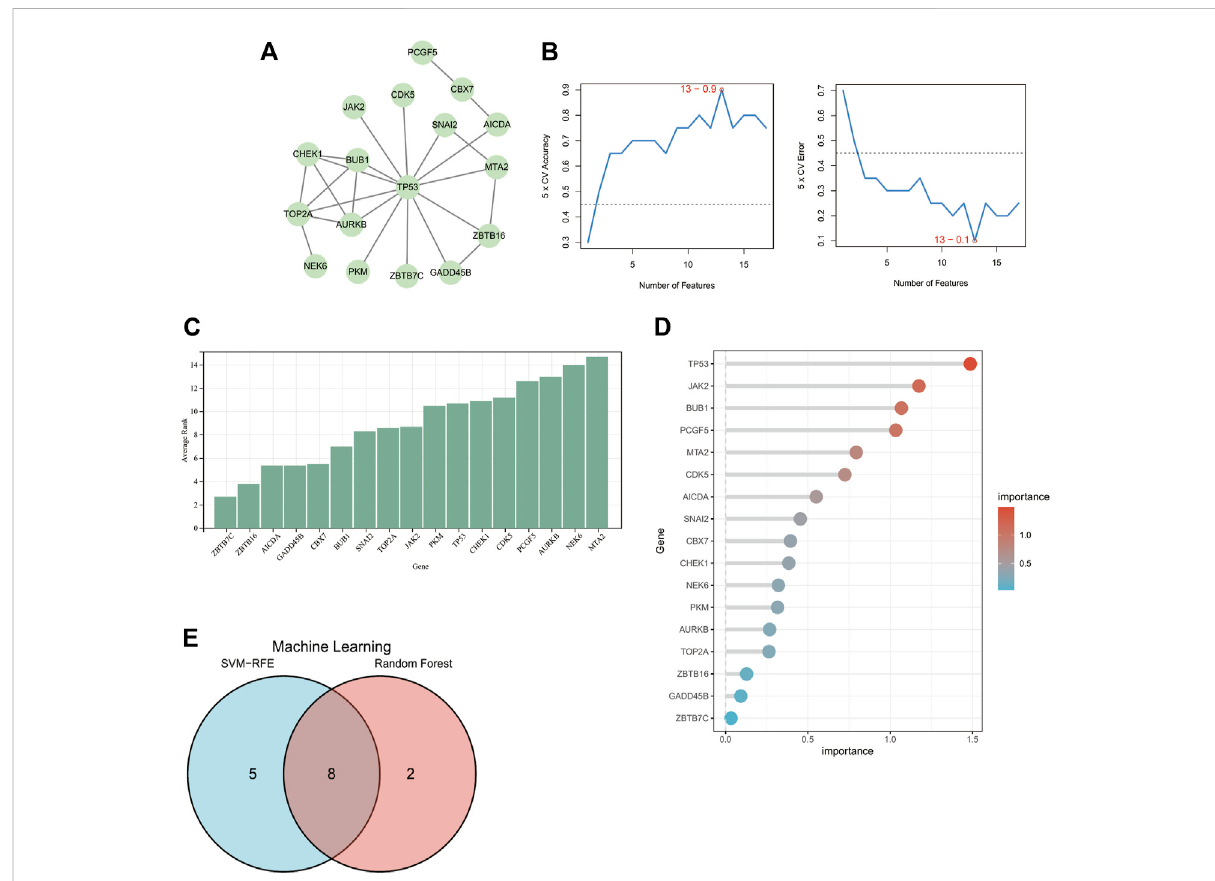
FIGURE 4 Identi fi cation of candidate DECRs for AD diagnosis. (A) The PPI network shows that 17 DECRs can interact with each other. DECRs devoid of interaction were eliminated. (B) The SVM-RFE machine-learning algorithm illustrates that, based on the 17 DECRs, the top-13 DECRs show the highest accuracy and lowest error for AD diagnosis. (C) DECRs wereranked based on calculationof average rank score fromSVM-RFE. Geneswith a lower rank denote a higher diagnostic value. (D) The importance score for each DECR can be visualized from the column using the random- forest algorithm. (E) The venn diagram shows that eight DECRs were fi ltered for subsequent evaluation of ROC curves. AbbreviationsDECRs, differentially expressed chromatin regulators; AD, aortic dissection; PPI, protein – protein interaction; SVM-RFE, support vector machine-recursive feature elimination; ROC, receiver operating